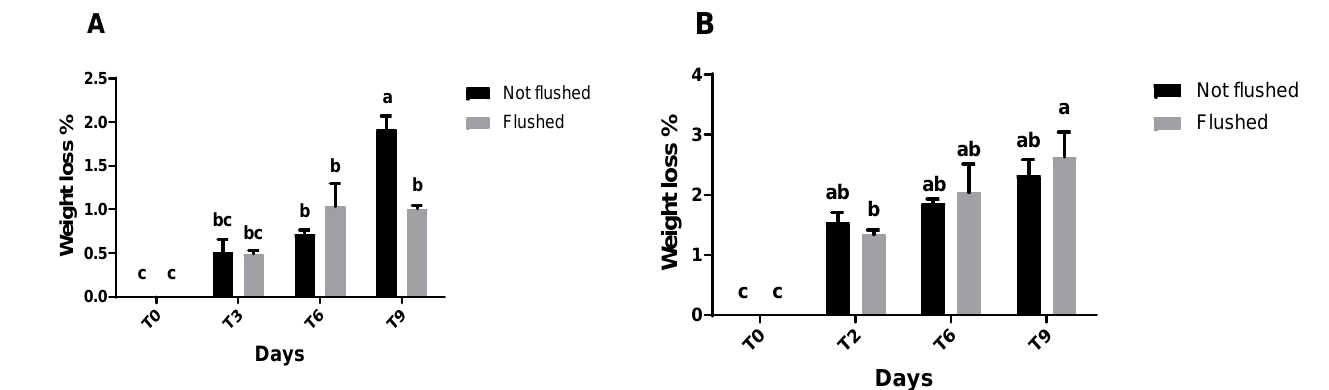
Figure 2. ( A ) Lactuca sativa weight loss (%) measured at harvest and three, six and nine days after harvest (data are mean ± SE, n = 4). ( B ) Eruca sativa weight loss (%) measured at harvest and two, six and nine days after harvest (data are mean ± SE, n = 3). Different letters represent significant differences ( p ≤ 0.05) among treatments and time points, calculated from a two-way ANOVA followed by Sidak’s test.